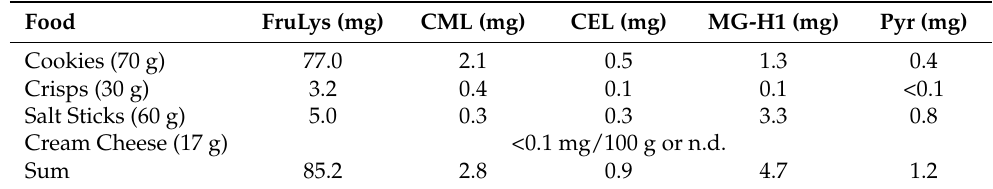
Table 3. MRP content of the intervention meal, food analysis was performed using LC-MS/MS analysis after enzymatic